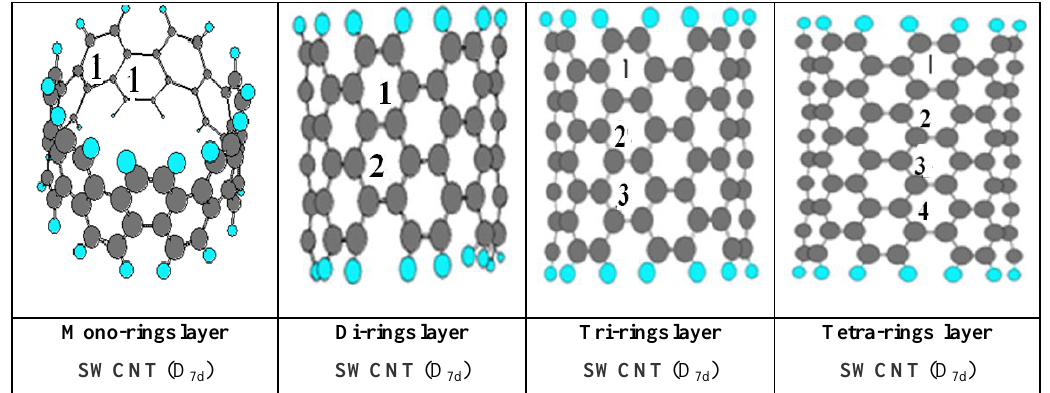
Fig.3: Equilibrium geometry for (mono, di, tri and tetra)-rings layer for (7,7) armchair single wall carbon nanotube (SWCNT) by using Mopac2000